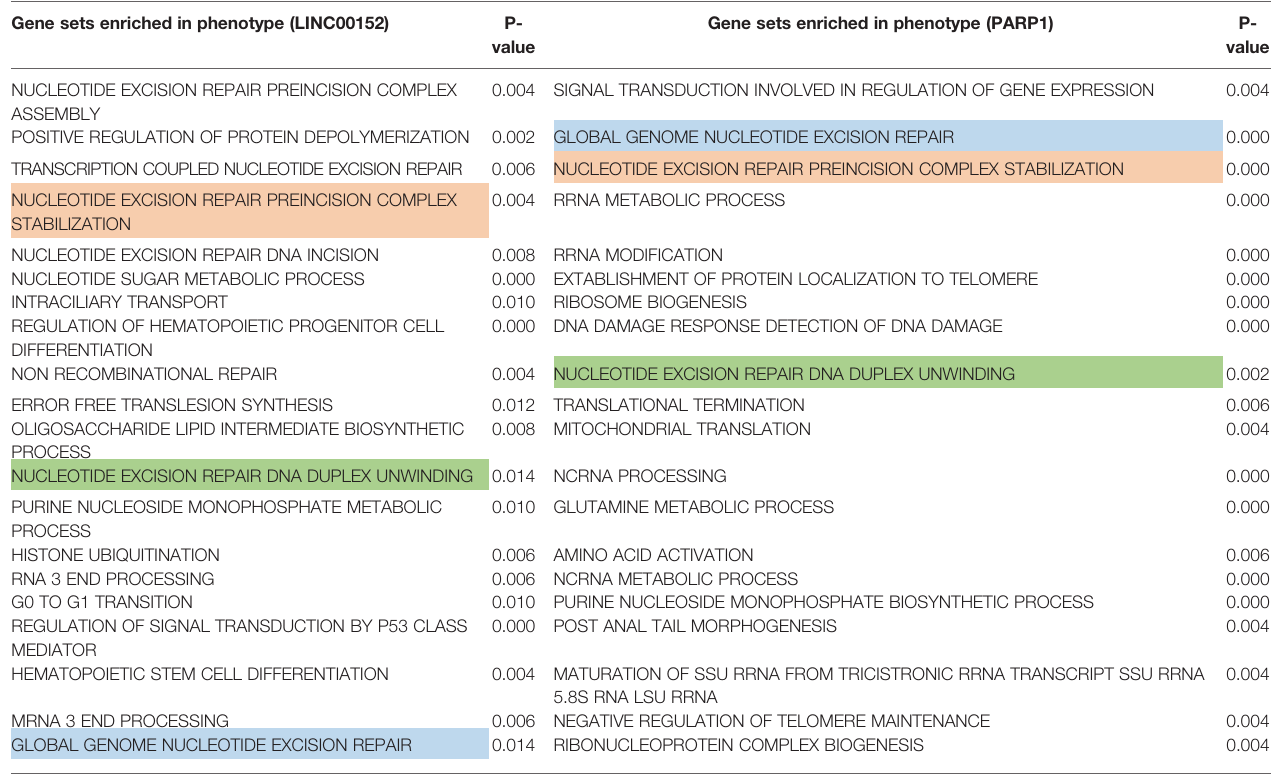
TABLE 1 | Gene Ontology